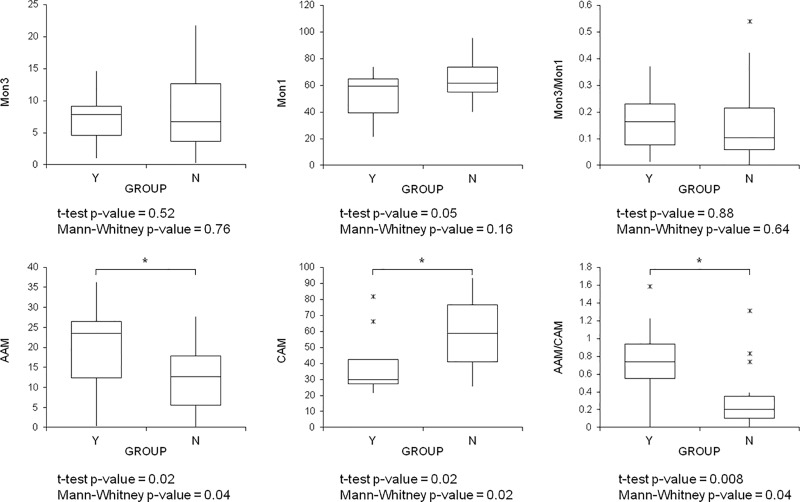
Box plots of predictors and related p-values for the t-test and Mann-Whitney test; Y indicates the group with maternal HCA, N the group without it.Asterisks (*) and horizontal bars indicate intergroup differences; p<0.05 was considered the limit for statistical significance. Box indicates medians with 25th and 75th percentiles, and whiskers indicate 5th and 95th percentiles; >95th or <5th percentiles are also shown (x).